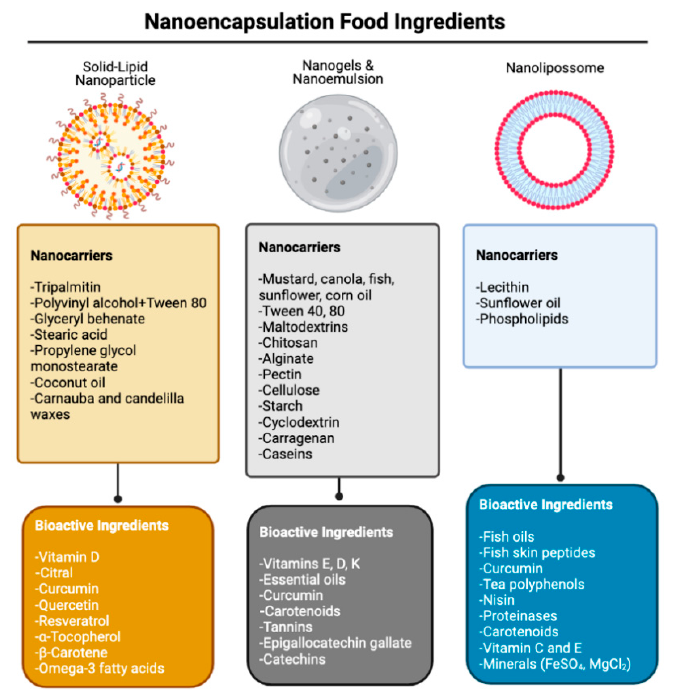
Figure 4. Scheme of the most commonly applied nanocarriers for bioactive compounds [16,107,108,117–120].